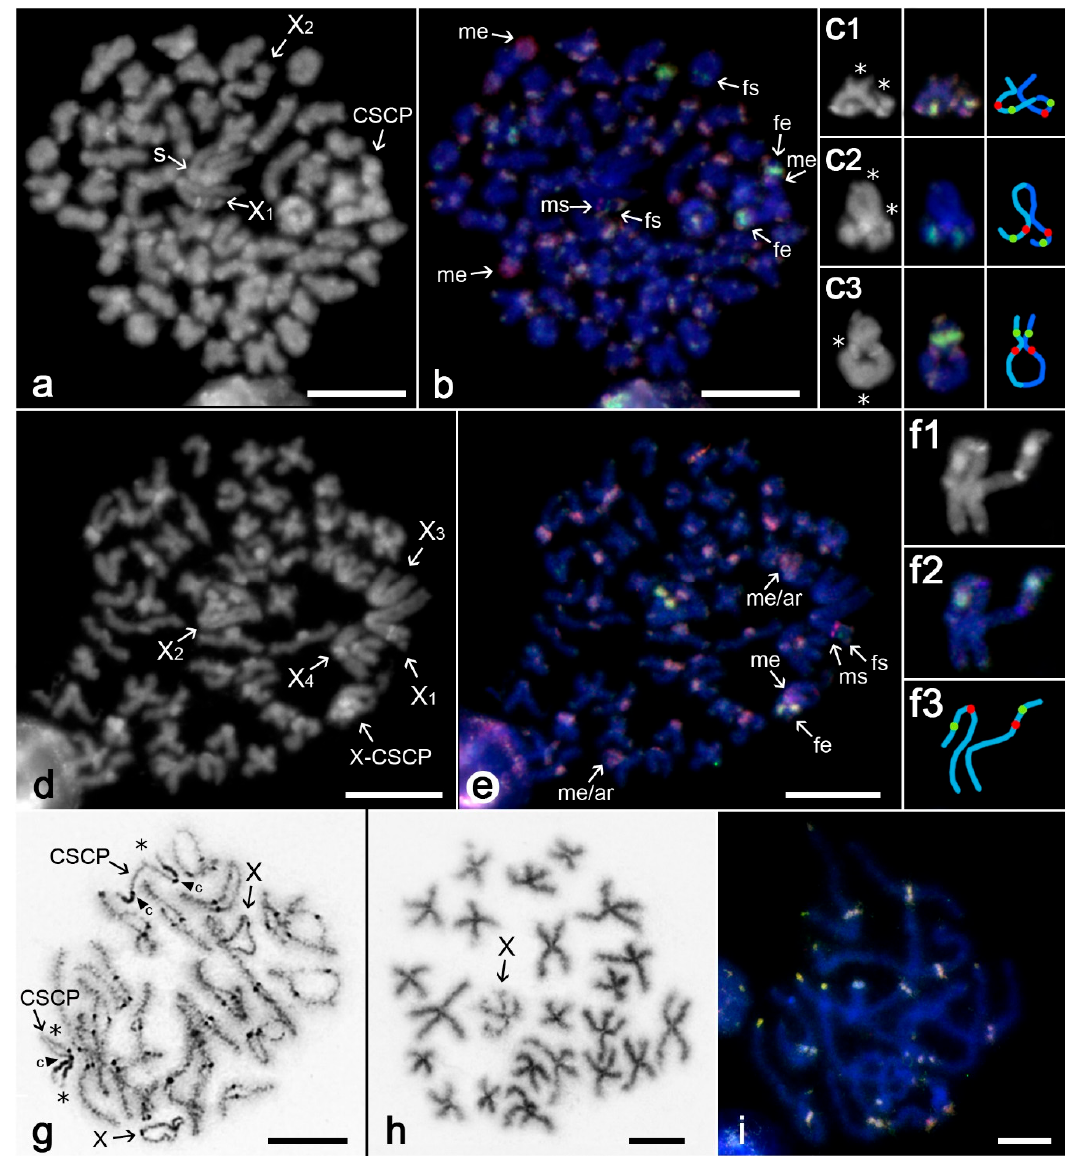
Figure 2. Comparative genomic hybridisation, theraphosid mygalomorphs Poecilotheria formosa ( a – f ) and Pterinochilus lugardi ( g – i ), male plates. Abbreviations: fs—female specific signal (green), fe—female enriched (i.e., biased accumulation of female probe) (greenish), ms—male specific signal (red), me—male enriched (i.e., biased accumulation of male probe) (reddish), s—X chromosome cluster, X-CSCP—X chromosome of CSCP. ( a – c ) P. formosa , metaphase I: ( a ) DAPI counterstaining. Some autosome bivalents exhibit a bright block at one or both ends, X 2 chromosome is partially released from the X chromosome cluster; ( b ) CGH. Highlighted sex chromosome regions: long arm of X 1 chromosome (two signals, female and male), CSCP (centromeres stained more intensely by female probe, an intercalar block at short arms highlighted predominantly by male probe). Some autosomes also contain blocks stained more intensely by male probe, and one bivalent has a tiny female-specific signal; ( c ) metaphase I, CSCP, pattern of chiasmata [from left to right: DAPI counterstaining, asterisk—chiasma; CGH; schematic drawing of bivalent (one homolog blue and another one light blue, green spots—female-enriched signals, red spots—male-enriched signals at centromere region)]. CSCP includes two chiasmata with pericentric ( c3 ), intercalar ( c1 , 2 ) or distal location ( c1–3 ); ( d , e ) P. formosa , metaphase II: X chromosomes (except for X 2 ) form a cluster on the plate periphery. Sister chromatids of multiple X chromosomes remain attached: ( d ) DAPI counterstaining. Centromeres of many (usually monoarmed) autosomes are AT-rich. AT-rich sex chromosome